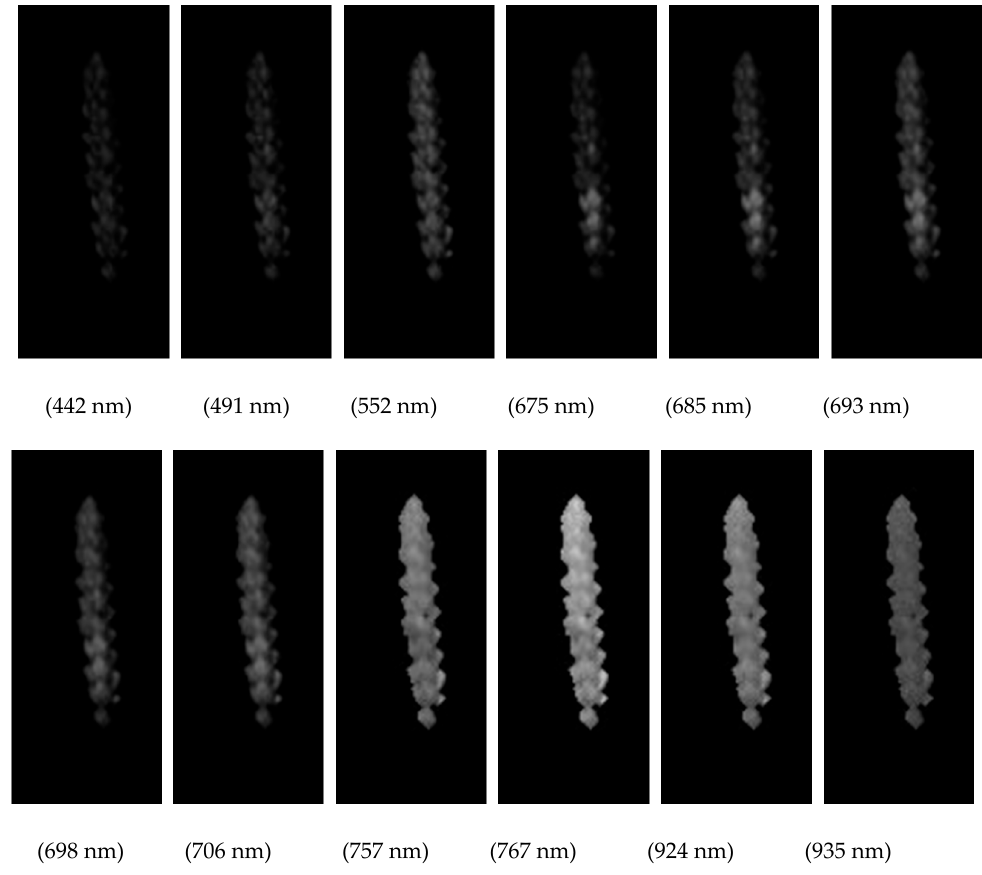
Figure 7. Twelve feature band images.